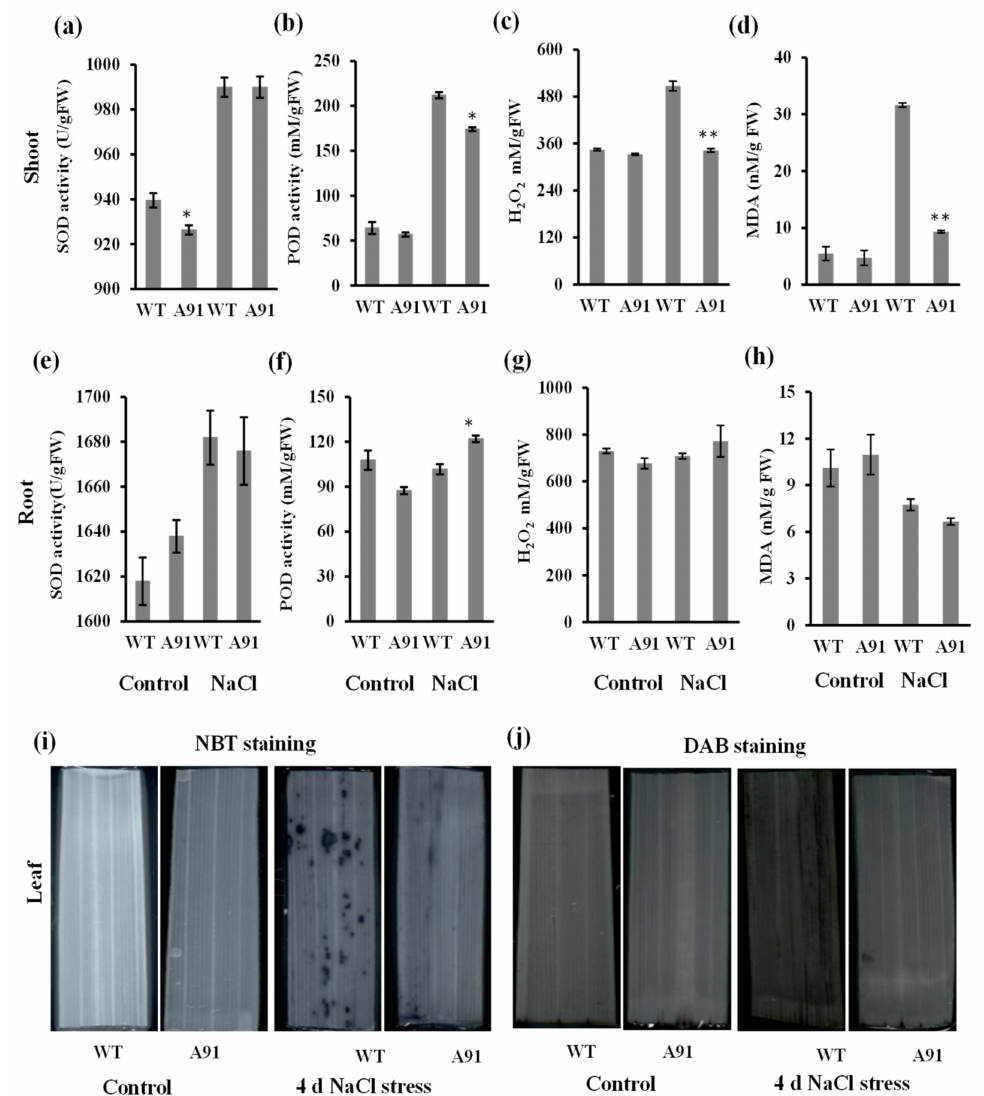
Figure 5. The oxidative stress in the shoot and root of WT and A91 seedlings under salt stress. ( a – d ) activities of SOD, POD, H 2 O 2, and MDA in shoot; ( e – h ) activities of SOD, POD, H 2 O 2, and MDA in the root; ( i ) NBT staining (indicates O 2 •− ); ( j ) DAB staining (indicates H 2 O 2 ); n = 3 biological replicates, data represent means ± SE; * and ** indicate significant t -test results at p < 0.05 and p < 0.01,